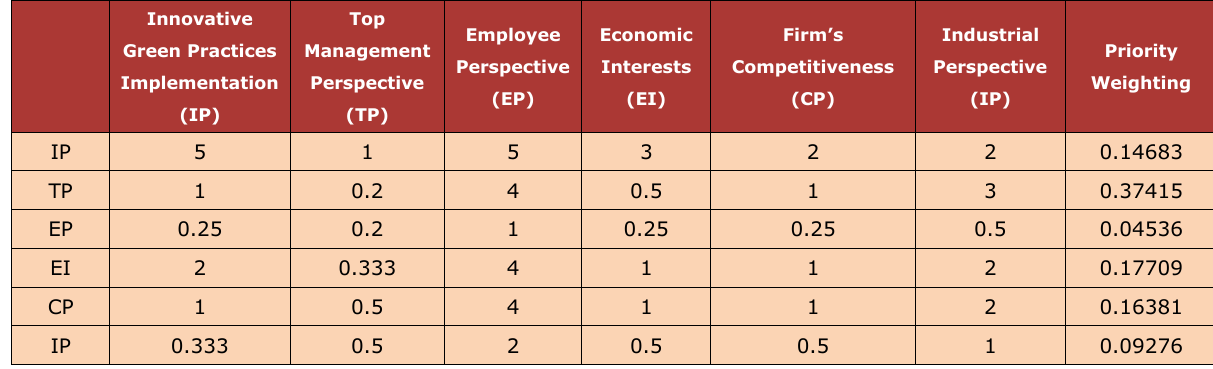
Table 5. Strategies of Organization perspective (Dimension